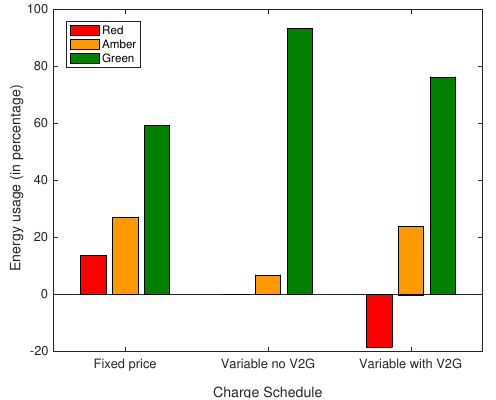
Figure 8. Energy usage across tariff regimes for personal